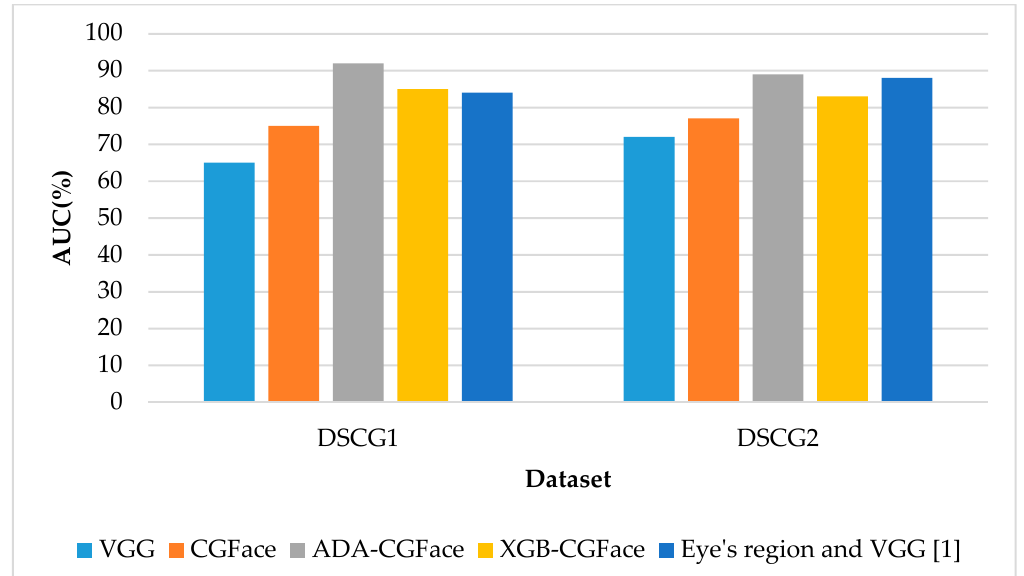
Figure 10. The AUC performance of the proposed models and two other models on different datasets.